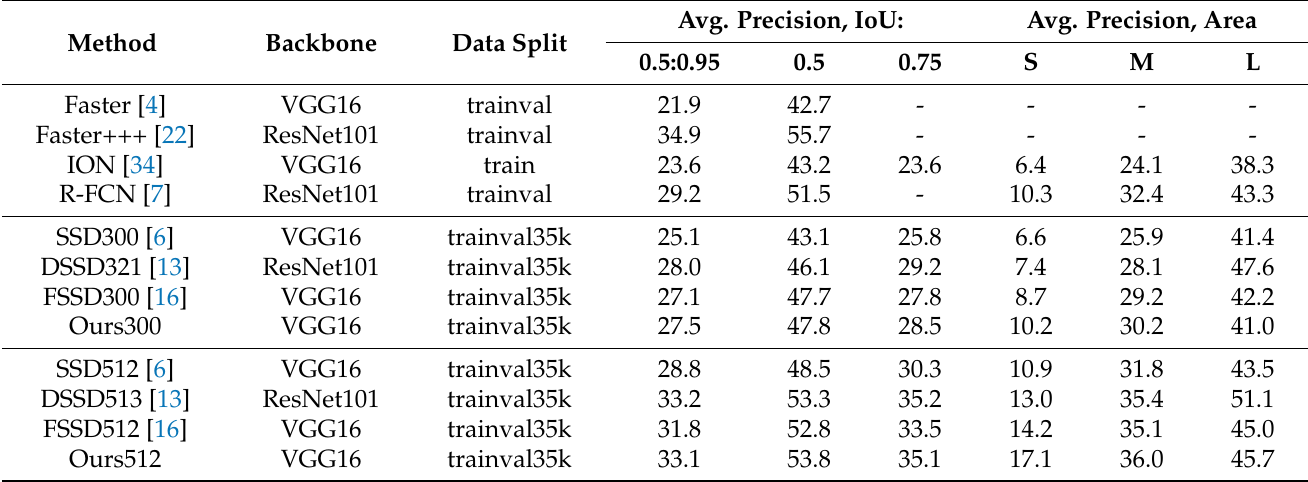
Table 4. MS COCO test - dev 2015 results. Note: The “+++” includes box refinement, context, and multiscale testing. Data from